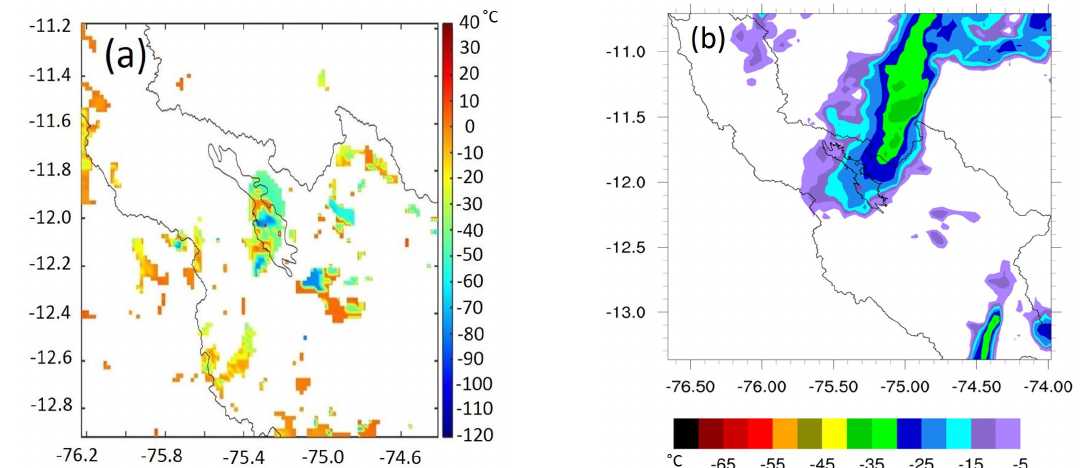
Figure 10. ( a ) Patterns of top cloud temperature obtained from the WRF model (resolution: 6 km) at 01 UTC (20 LT); ( b ) Patterns of cloud brightness temperature around the Mantaro valley from GOES at 01 UTC (20 LT). The geographic boundaries of the Mantaro basin and the Mantaro valley are